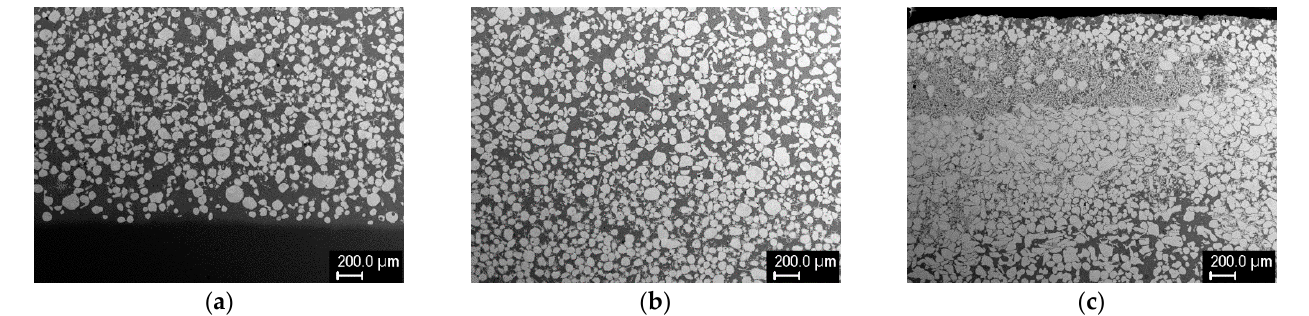
Figure 9. Cross sections of three-layer W–Cu cladding on a steel substrate: ( a ) one-layer (75% W), ( b ) two-layer (75% + 95% W), ( c ) three-layer (75% + 95% + 98% W).